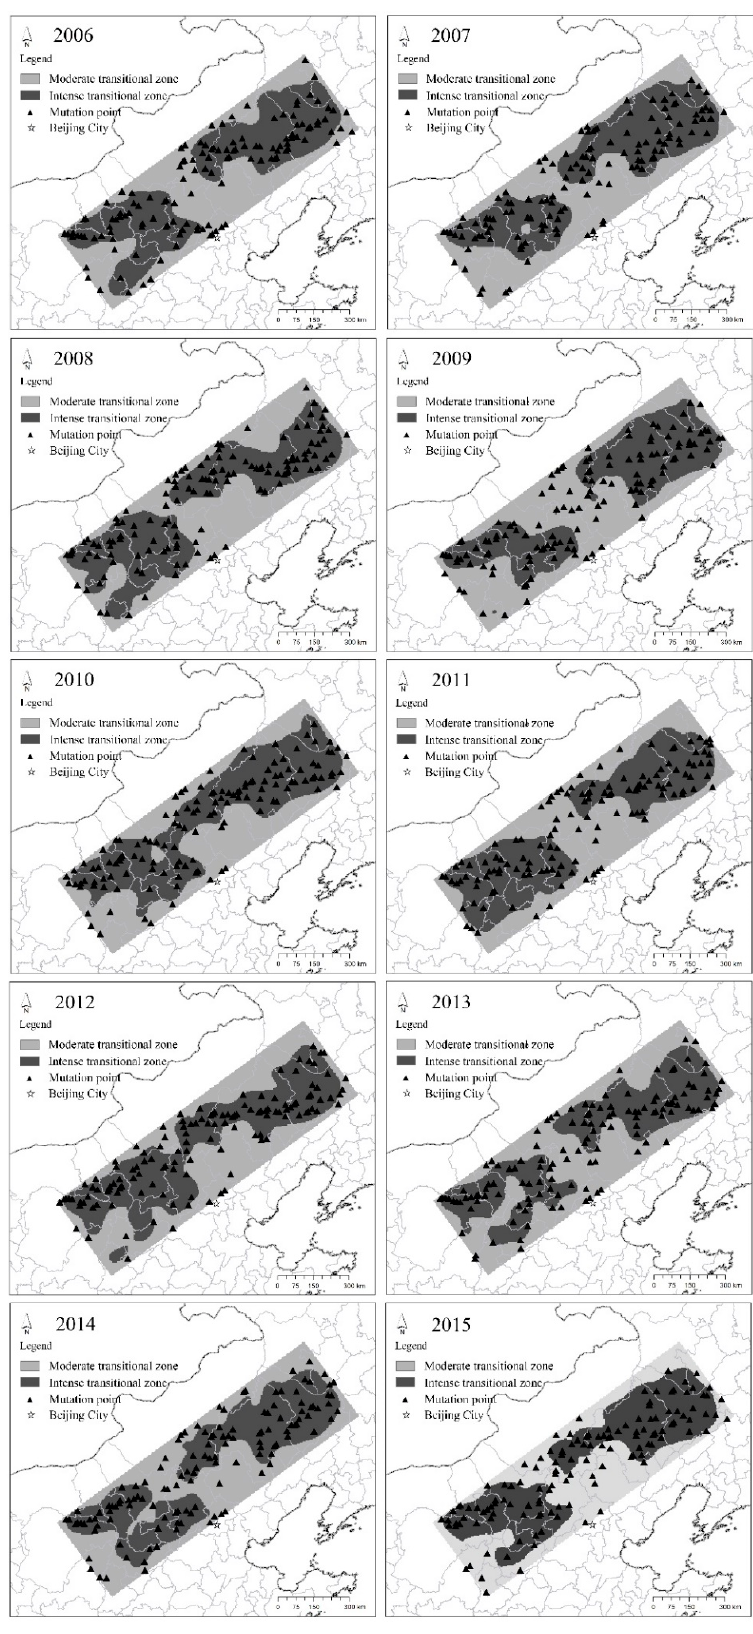
Figure 4. Temporal change of the agro-pastoral transitional zone (APTZ) and the spatial distribution of mutation points (2006–2015).